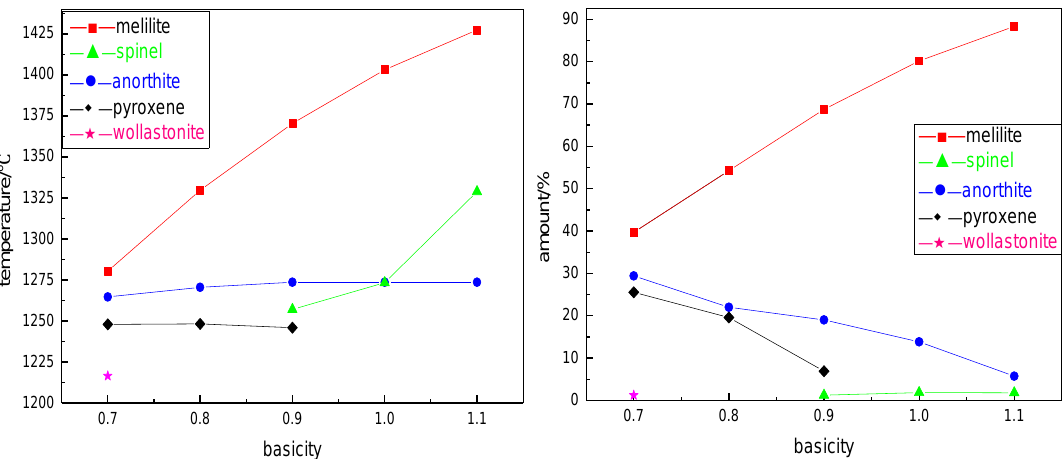
Figure 2. Crystallization temperature and crystallization amount for minerals with different basicities. With the increase of basicity, due to the relative decrease of Mg 2+ and Si 2+ in the slag, the precipitation amount of pyroxene and wollastonite in BFS decreased gradually, and did not precipitate when the basicity was 0.9. The spinel began to crystallize when the basicity increased to 0.9. At the same time, the precipitation amount of melilite and spinel increased from 39.69% and 1.24% to 88.32% and 1.83% with the increase of basicity, respectively. The precipitation amount of anorthite decreased from 29.42% to 5.74%. The initial crystallization phases were all melilite and the crystallization temperature of BFS were 1280.40 °C, 1329.70 °C, 1370.4 °C, 1403.20 °C, and 1427.40 °C